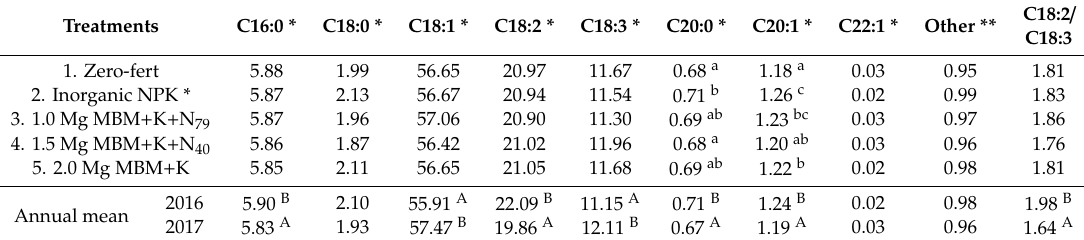
Table 3. Fatty acid profile of rapeseed oil